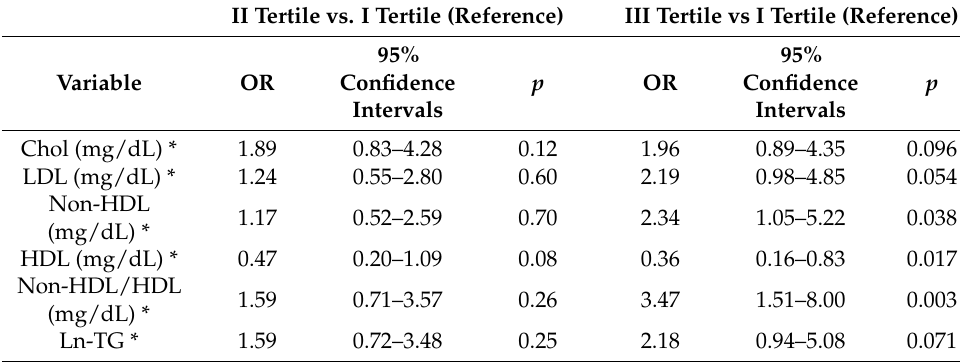
Table 3. Association between tertiles of lipid parameters and carotid plaques. II Tertile vs. I Tertile